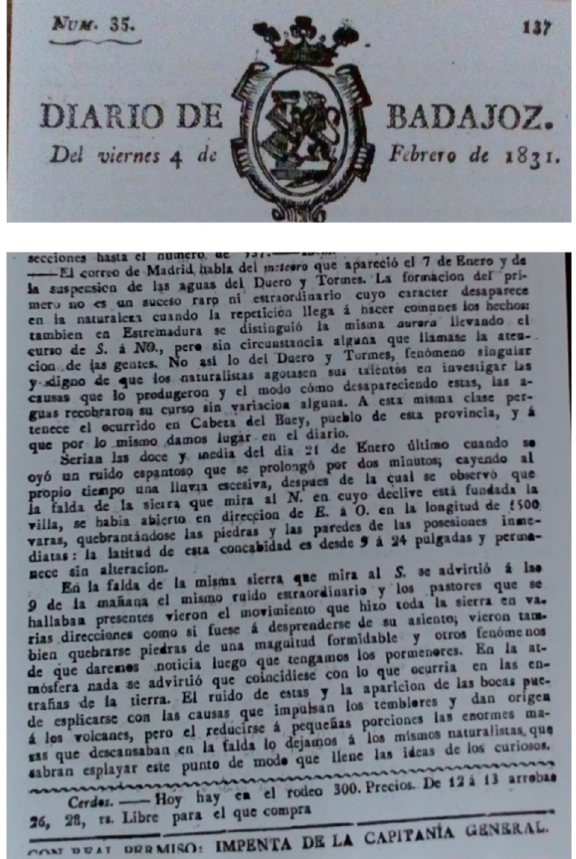
Figure 4. Article of 4 February 1831, from “Diario de Badajoz”